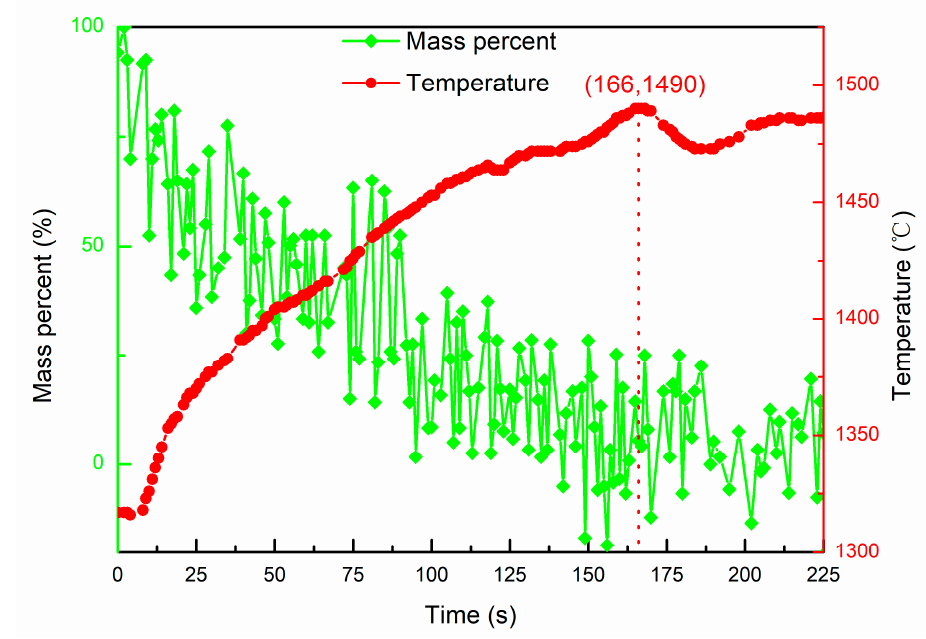
Figure 2. The vacuum evaporation of Al by EBM.